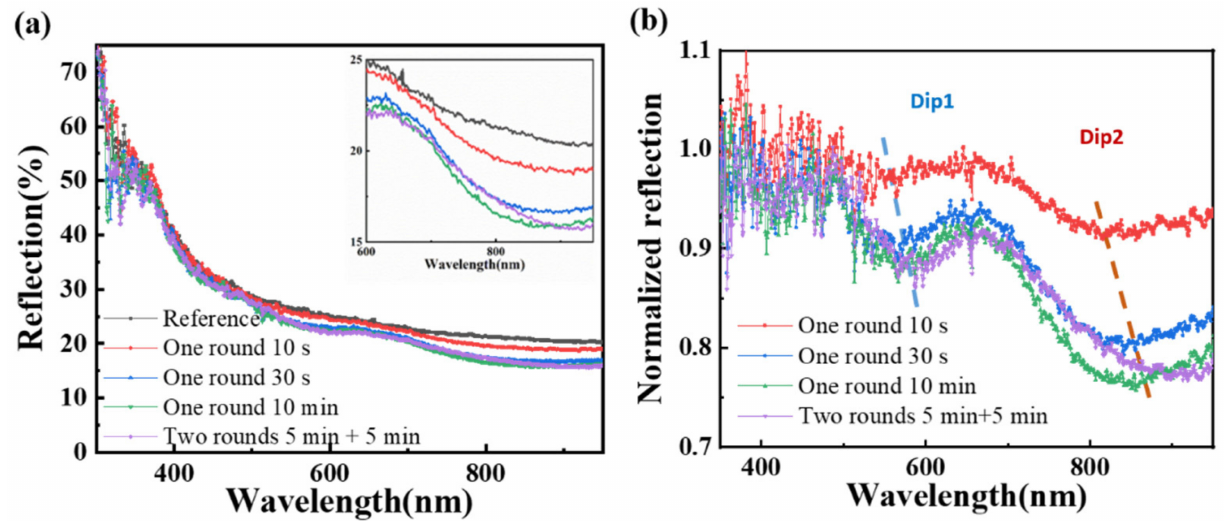
Figure 8. The reflection spectra analysis: ( a ) Reflection spectra from the textured solar cells without or with SiO 2 nanocoating. The inset graph is the magnified reflection spectra over the wavelength range from 600 nm to 950 nm; ( b ) Normalized reflection spectra of the textured solar cells with SiO 2